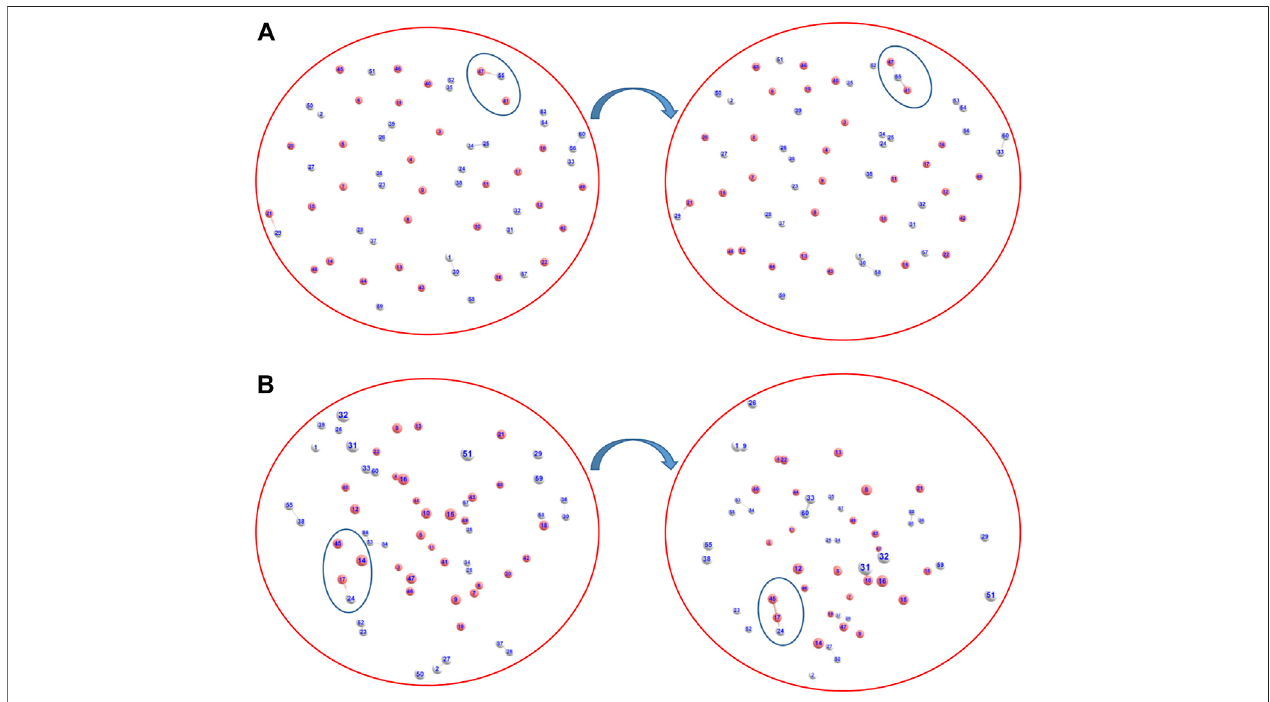
FIGURE 2 | Snapshots of AINR simulations revealing the pathway toward the making of He 2 H + , in the form of (A) [He-H-He] + and (B) [He-He-H] + (Color: He - peach, H - white).